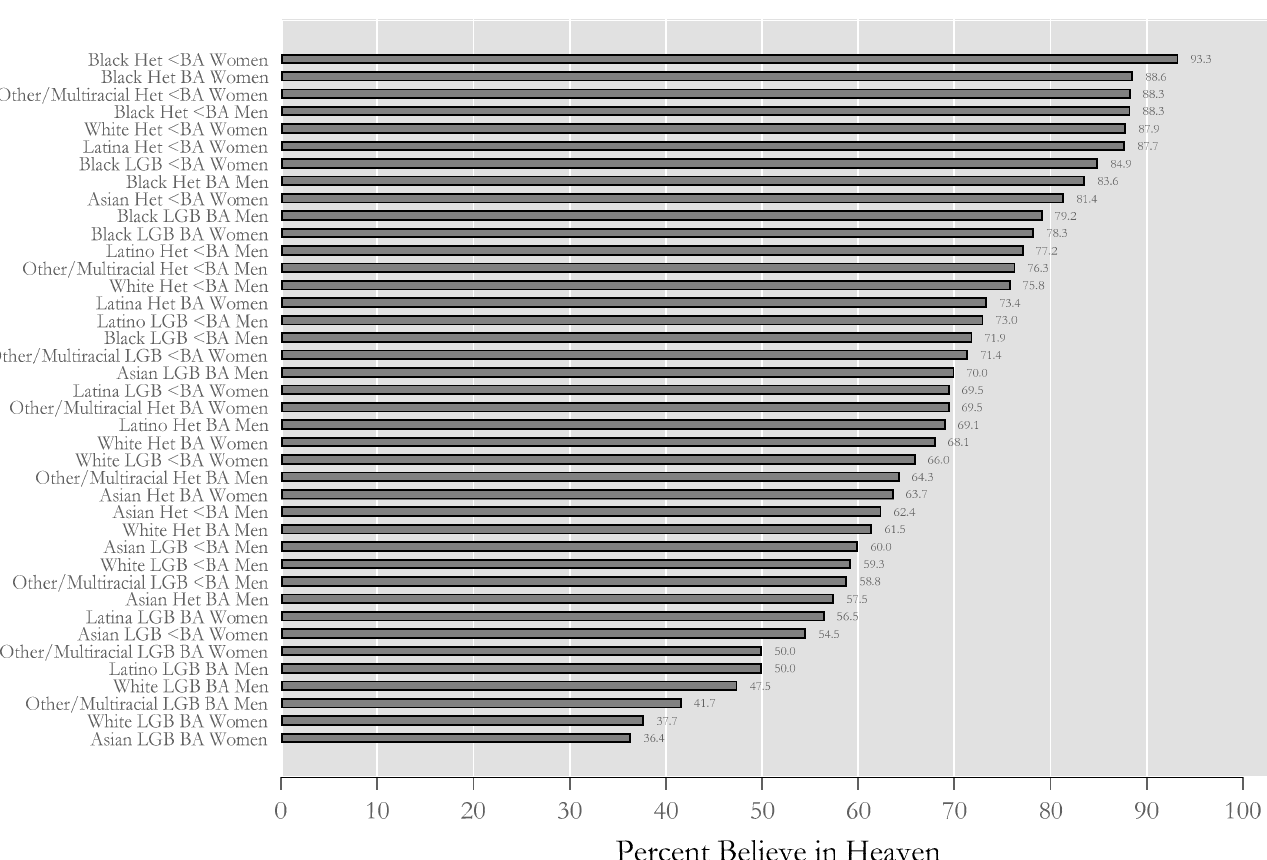
Figure A4. Belief in Heaven, RLS (N = 30,930).